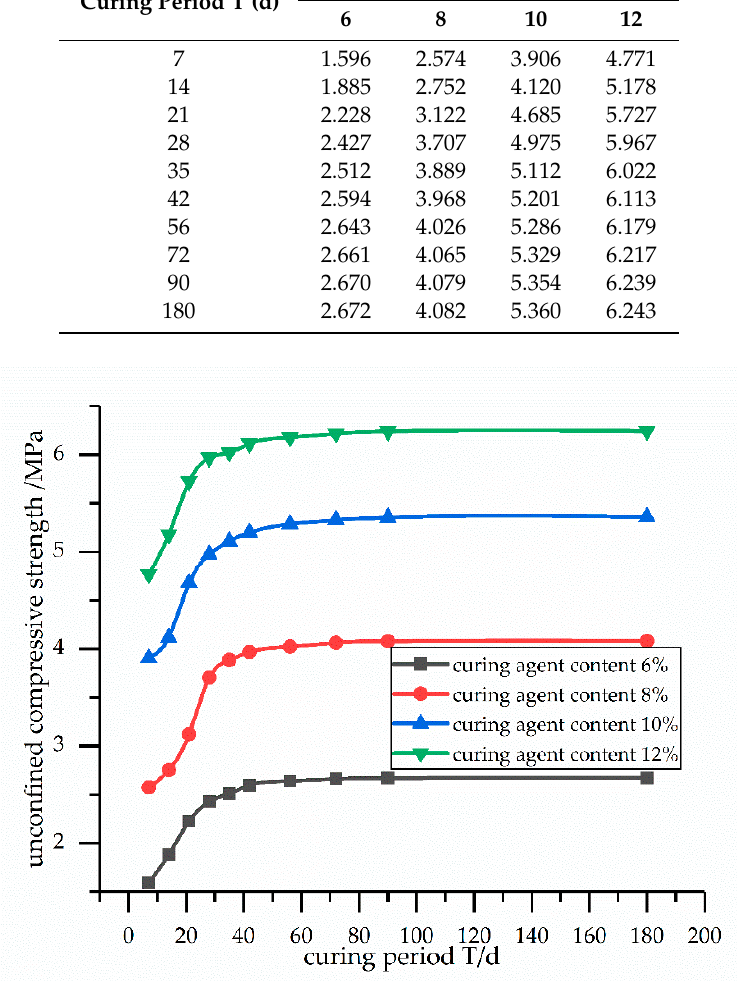
Figure 3. Relationship between the unconfined compressive strength and the curing period.